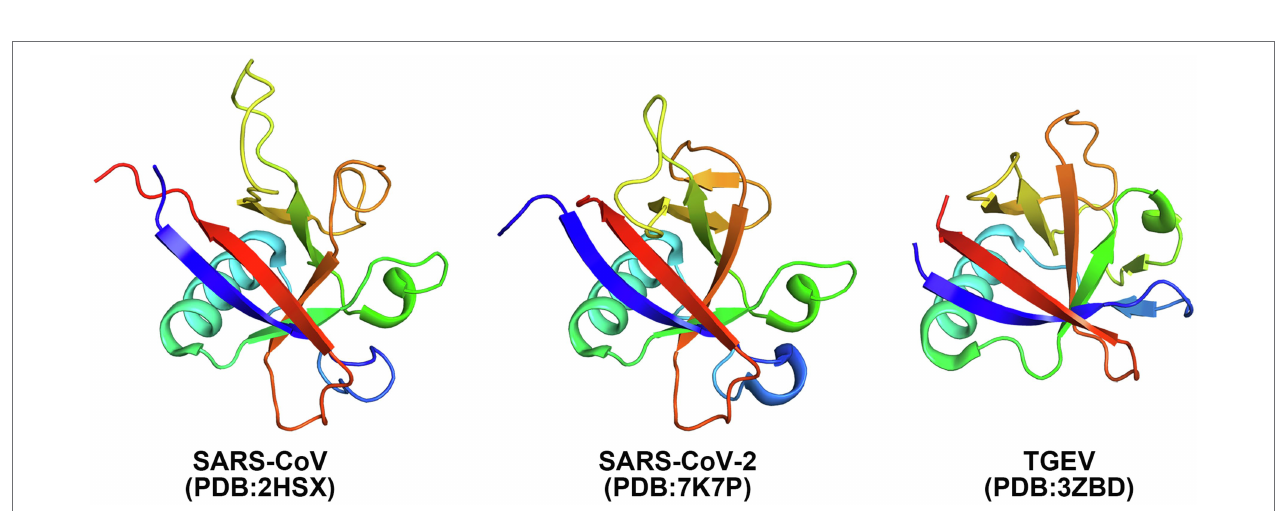
FIGURE 3 | Crystal structures of Nsp1 of SARS-CoV (PDB: 2HSX), SARS-CoV-2 (PDB: 7K7P), and TGEV (PDB: 3ZBD) shown in cartoon. Rainbow coloring from blue to red indicates the N- to C-terminal positions of the residues in the